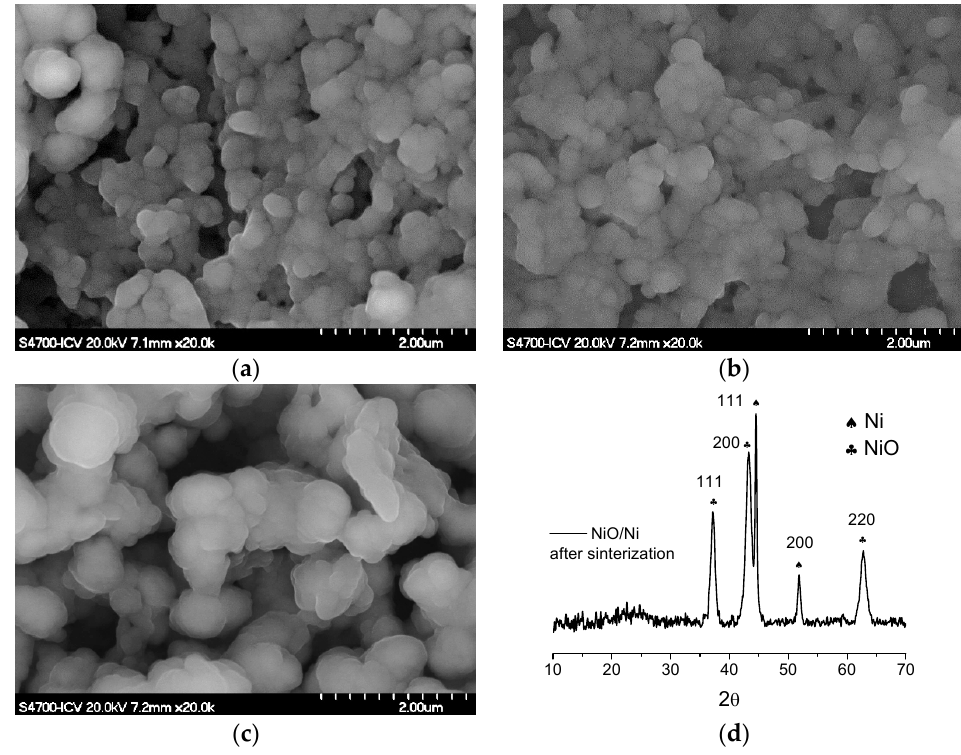
Figure 6. Final morphology and porosity of the NiO ‐ Ni coating after the different heat treatment: ( a ) 325 °C 15 min Ar, ( b ) 375 °C 15 min Ar, and ( c ) 325 °C 60 min Ar; ( d ) XRD patterns of the NiO ‐ Ni powders after calcination and scraping from the substrates.